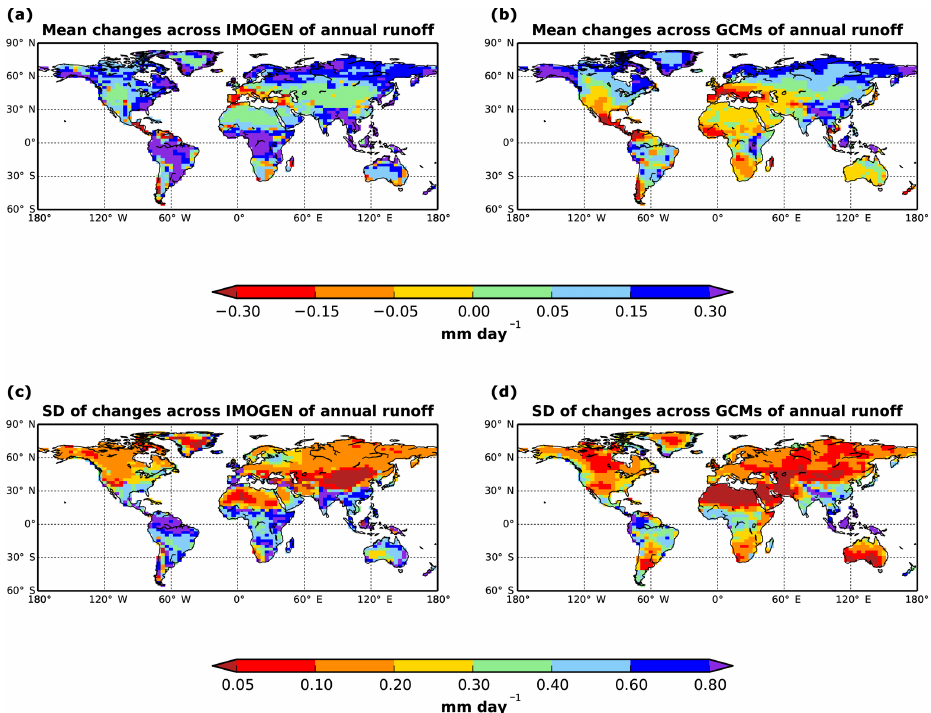
Figure 7. Comparison of IMOGEN and GCM estimates of annual mean runoff changes. This is for 20 years centred on 2090 minus 20 years centred on 1900, and for emissions scenario SRES A1B. (a) shows the mean changes in runoff across GCMs emulated in the IMOGEN system, all forcing the JULES land surface model. (b) shows the mean changes in runoff as taken directly from the GCMs themselves. (c) , at each grid box, presents the SD of changes in runoff for IMOGEN, again across GCMs emulated. (d) shows SD of changes in runoff taken directly from the